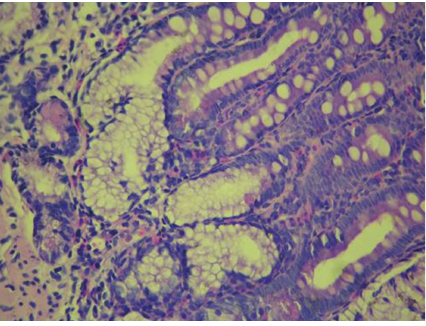
Figure 3: Pyloric metaplasia at the base of the crypt